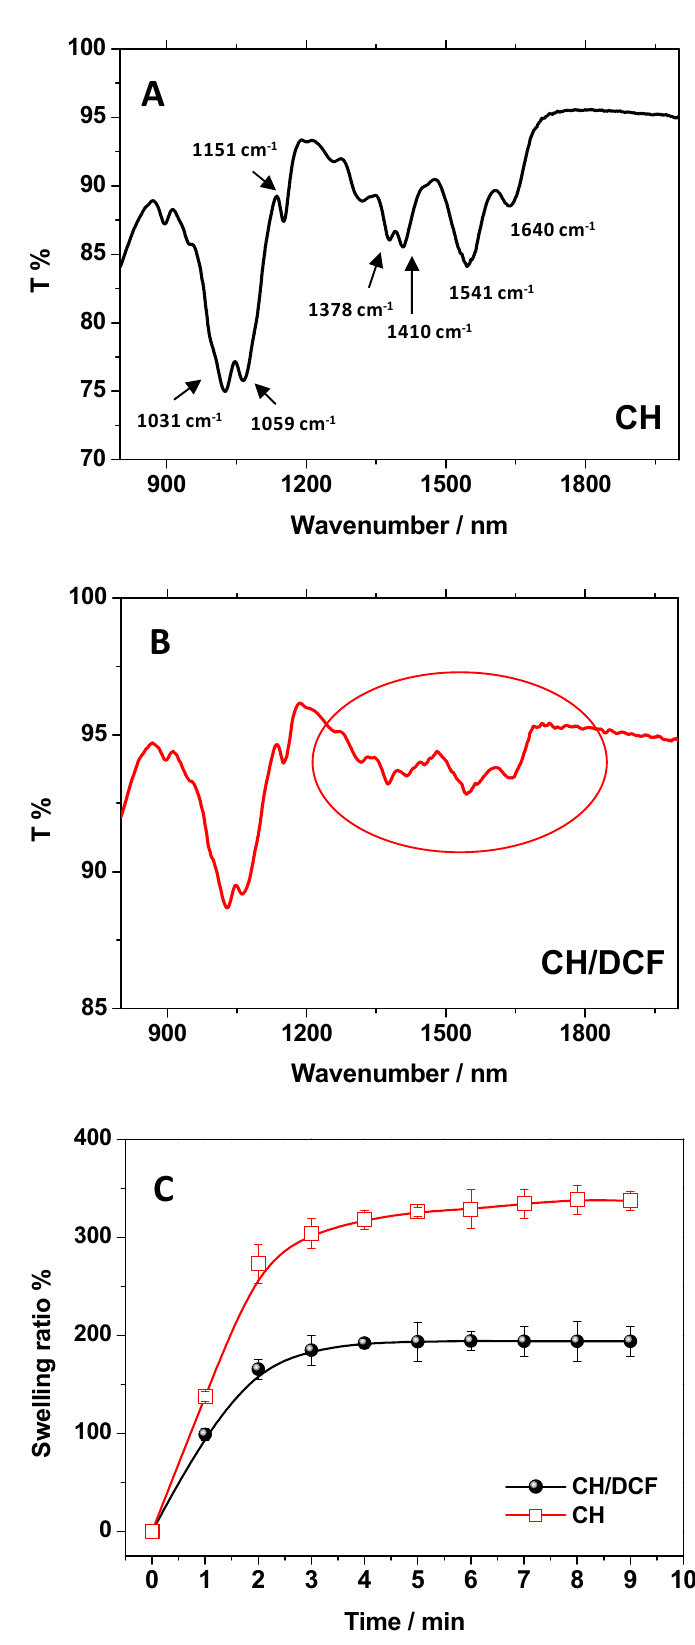
Figure 3. FTIR-ATR measurements (detailed wavenumber region 600–2000 cm − 1 ) of ( A ) CH, ( B ) CH / DCF, and ( C ) swelling ratio measurements of CH and CH /